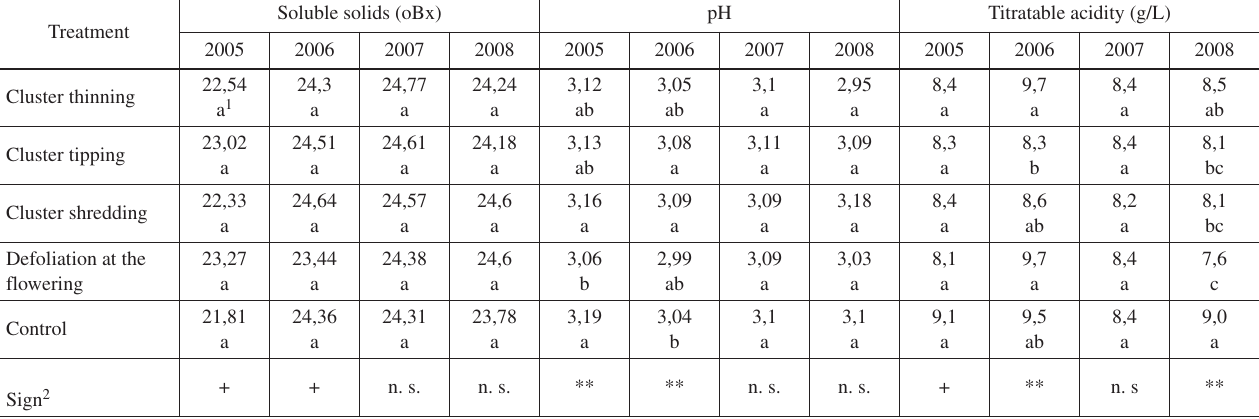
1 Means within columns followed by different letters differ significantly at p<0,05. 2 +, *, **, ns: significant at p<0,10, 0,05; 0,01, or not significant, respectively.